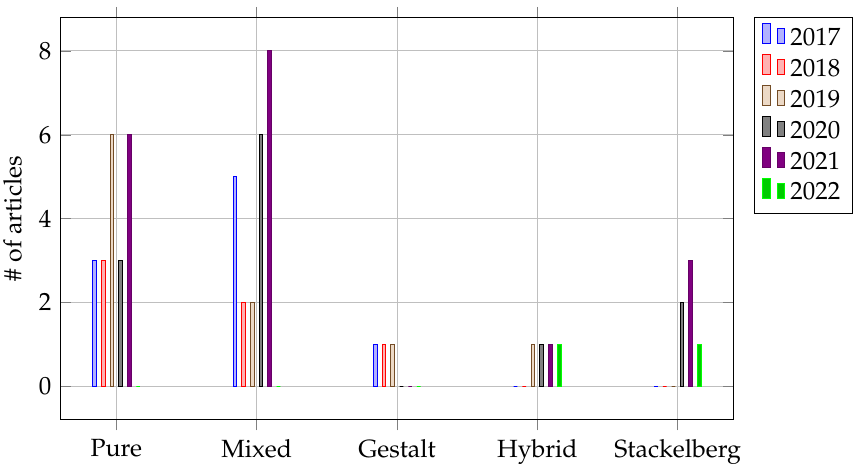
Figure 6. Publication output by year based on game-theory strategies against